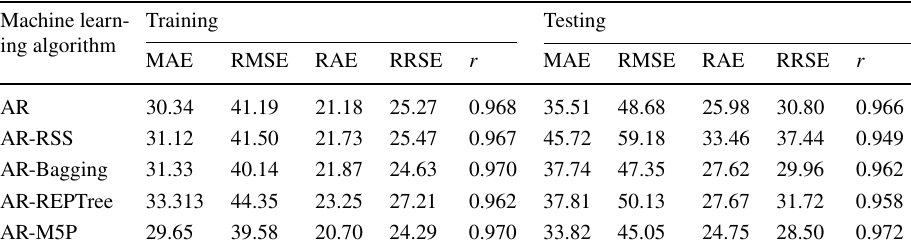
Table 7 MAE, RMSE, RAE, RRSE, and r for meta-heuristics algorithms-based models during the training and testing span at Baghdad